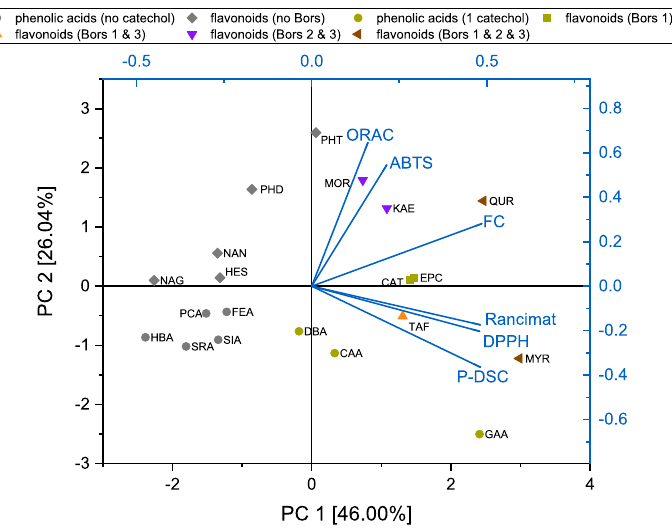
Figure 3. PC analysis of results from Rancimat and the P-DSC, ABTS, DPPH, FC, and ORAC assays presented in dependence of subgroups and structural